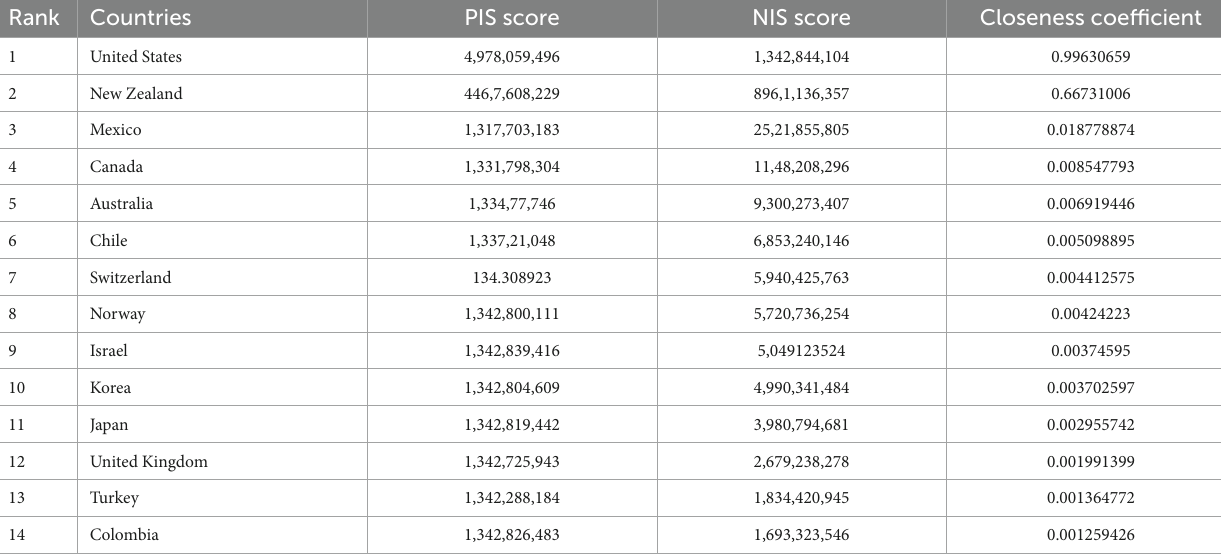
TABLE 8 Rankings of 14 OECD countries from least to most food insecurity risk